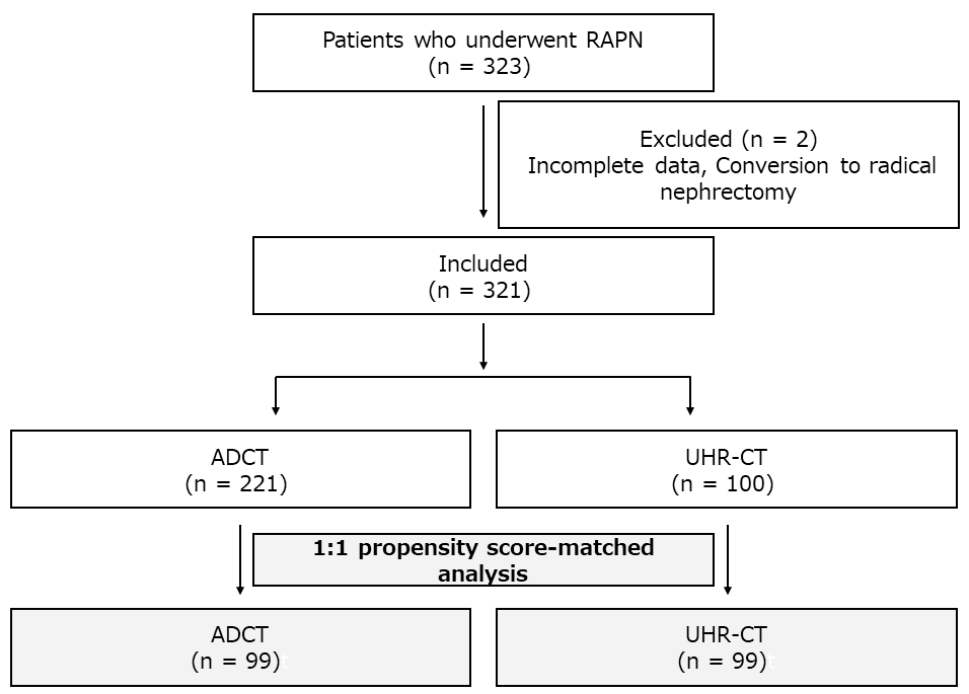
Figure 2. Flowchart of the patients enrolled in the study.